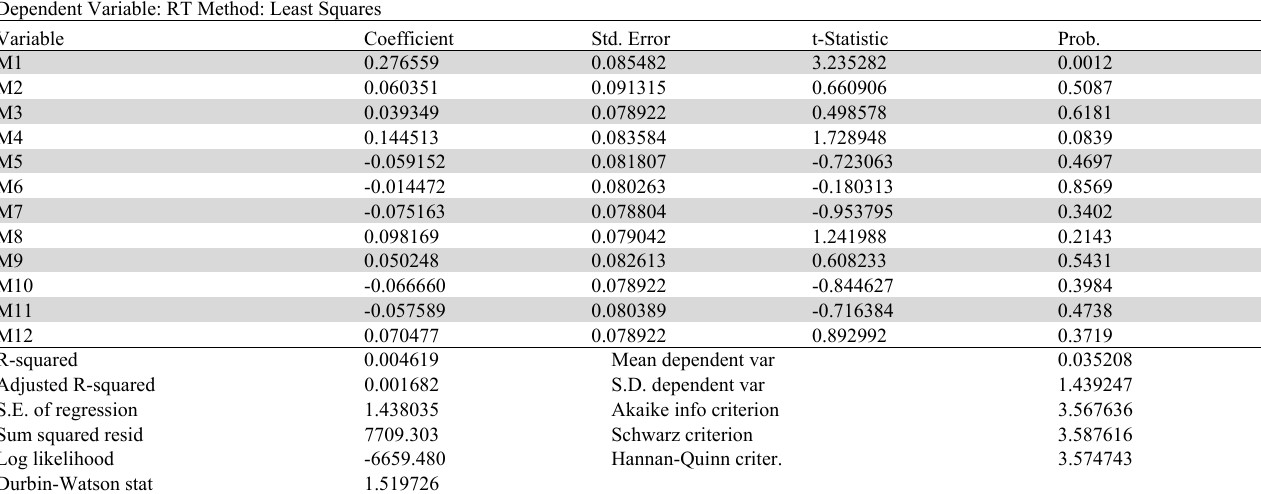
Results of OLS estimation procedures for VN-Index daily